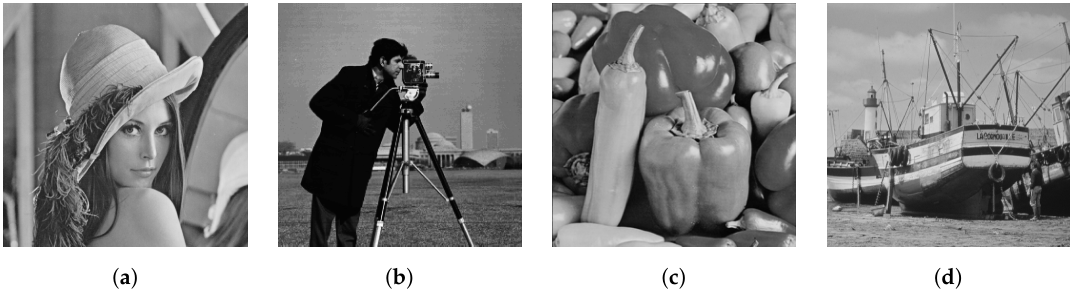
Figure 3. Original images. First column: image name. Second column: image size. ( a ) Lena: 512 ×